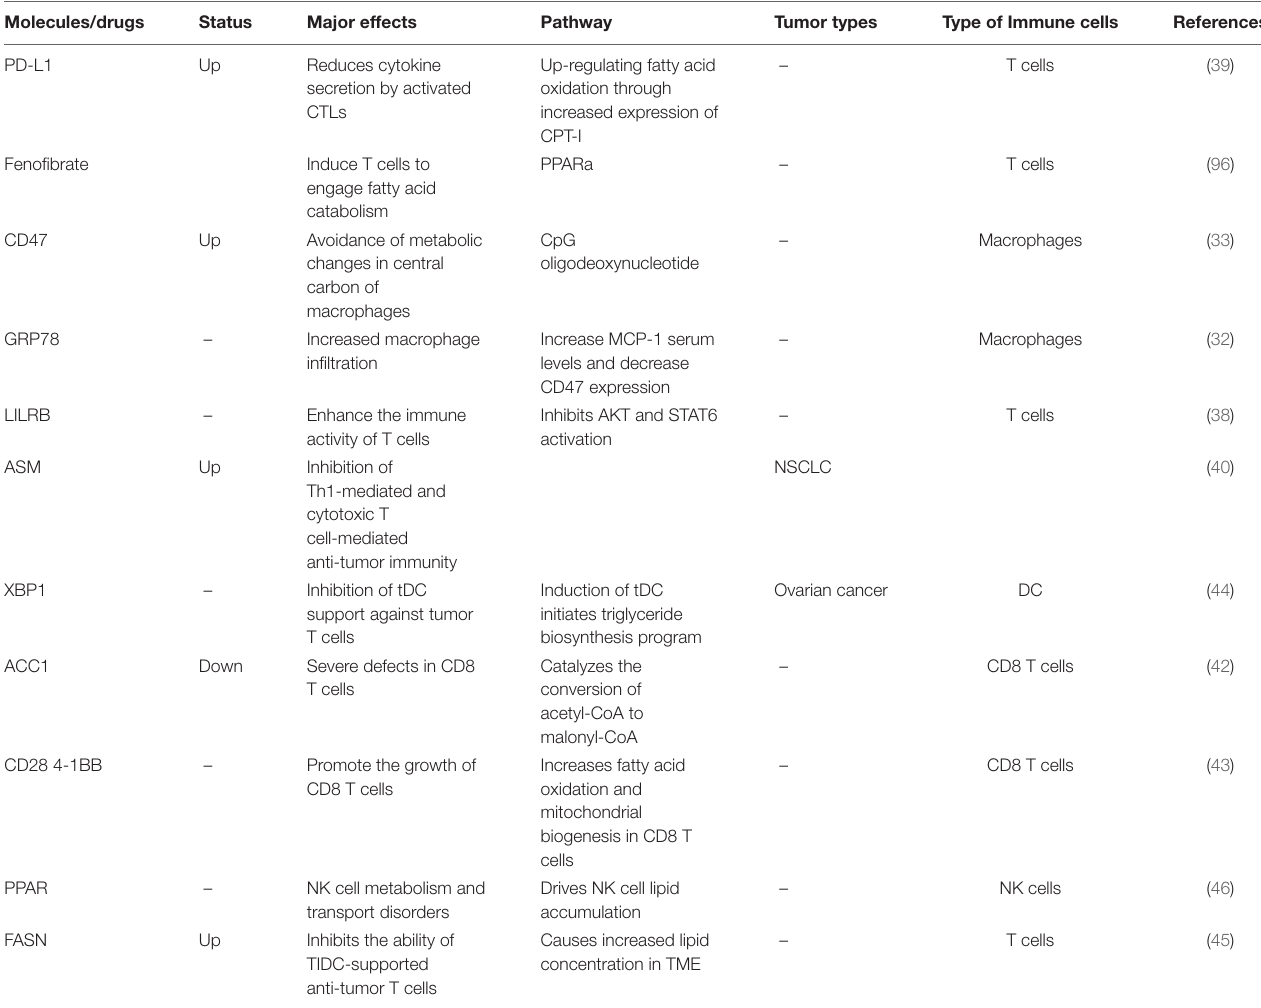
TABLE 2 | Fatty acid metabolism and tumor